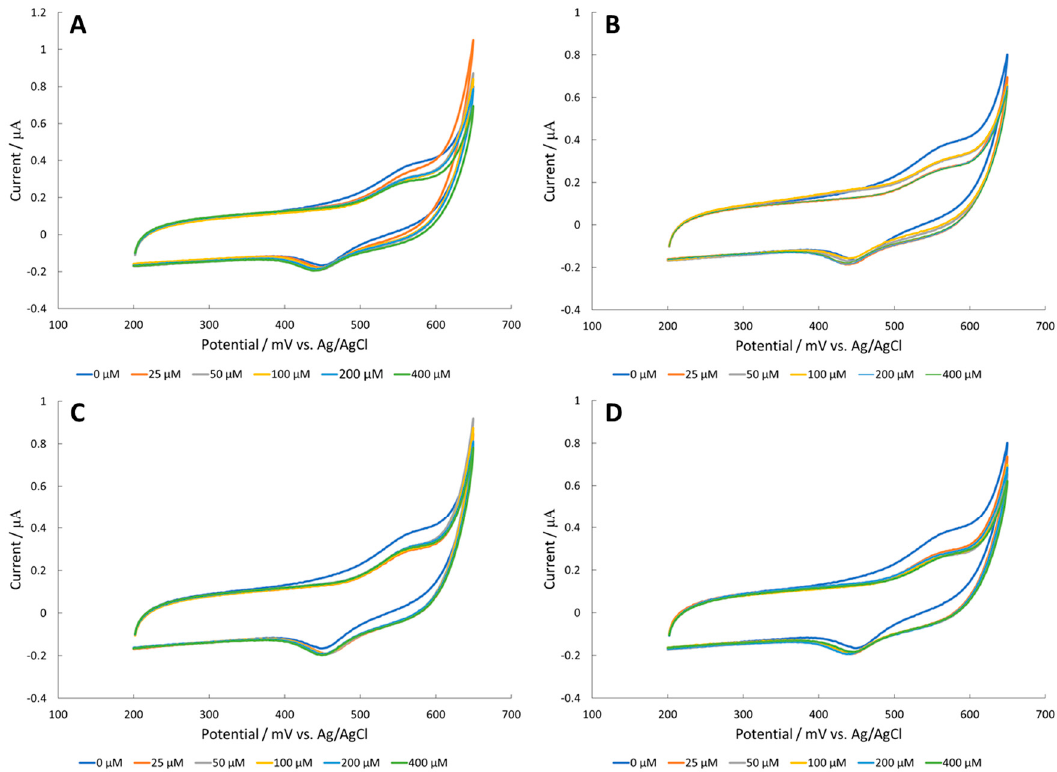
Figure 4. CV of ( A ) alanine, ( B ) arginine, ( C ) serine, and ( D ) valine in 100 mM NaOH with an Fe 2 O 3 modified glassy carbon electrode.